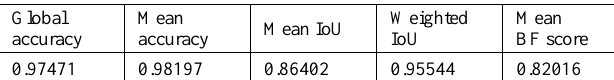
P ERFORMANCE OF THE SSN T RAINED FOR 33 E POCHS BY F IG . 4 W ITHOUT D ROP O UT